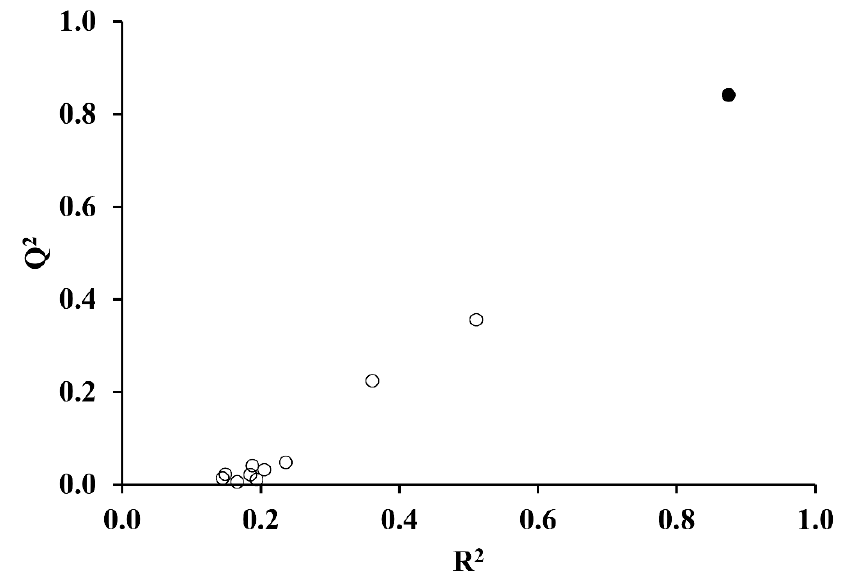
Figure 4 . Randomness test performed on the selected regression model, Equation 2 .